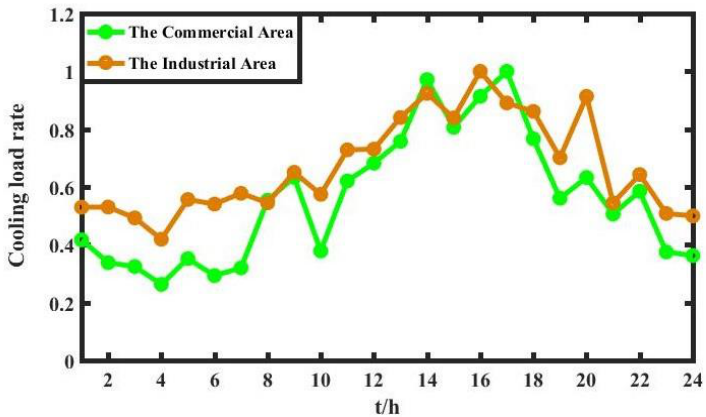
Figure 2. Typical cooling load rate curves of multiple functional areas.